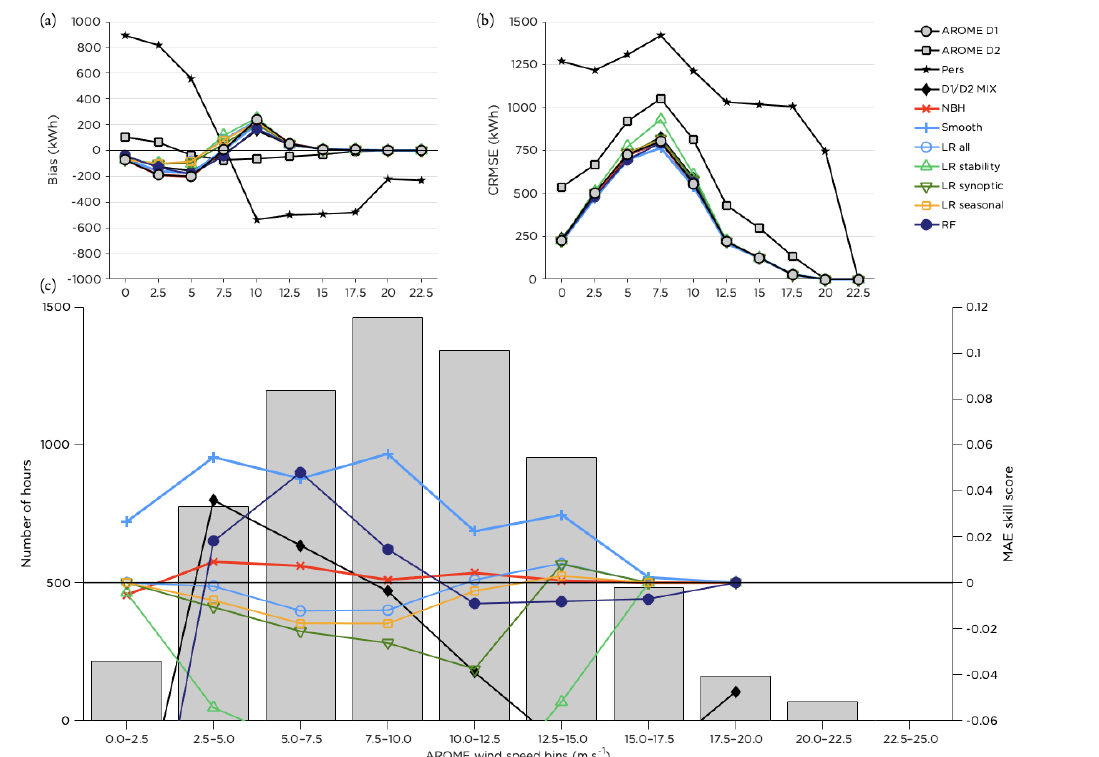
Figure 9. Performance of the post-processing methods for different wind speed bins. Panel (a) shows the bias, panel (b) the CRMSE and panel (c) the MAE skill score for the methods with the highest scores together with the distribution of the number of hours forecasted within each bin during the test